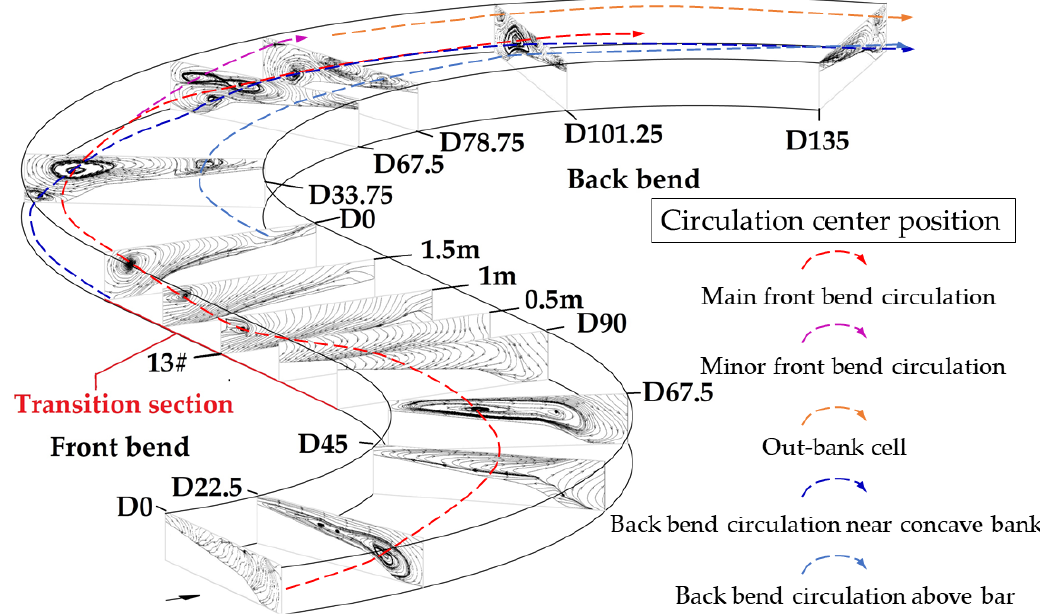
Figure 3. Distribution of circulation structures along the continuous bend at Q3. The direction of the arrow in the typical section is the flow direction. The red, purple, orange, dark blue and blue dotted lines denote different circulation centre positions along the continuous bend, respectively.